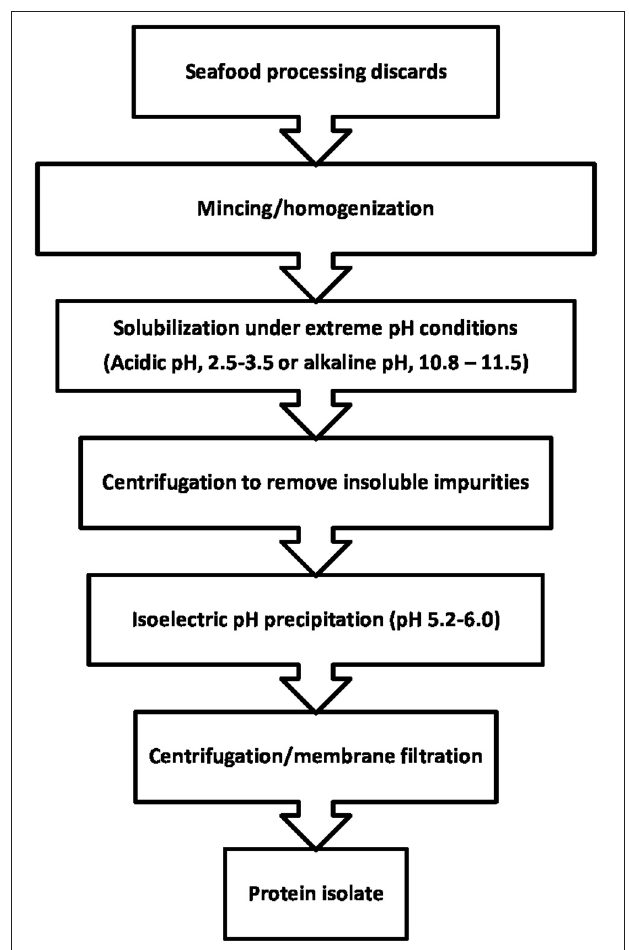
FIGURE 2 | Recovery of proteins from seafood discards by isoelectric solubilization precipitation (Adapted from Hultin et al., 2005).